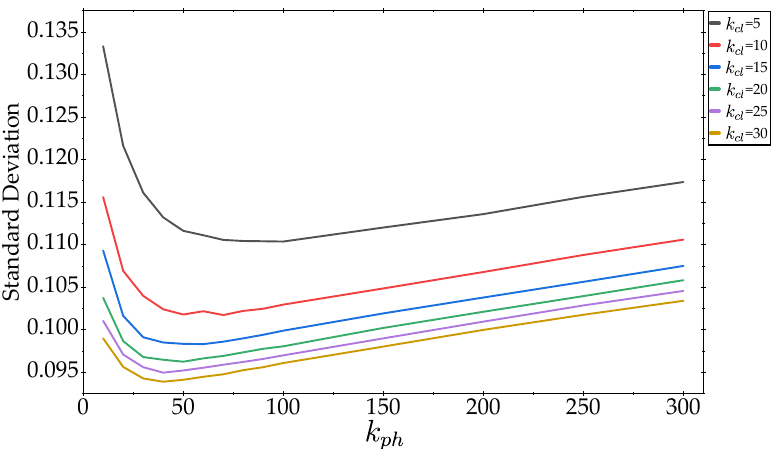
Figure 19. Mean values of images’ standard deviation with different parameter